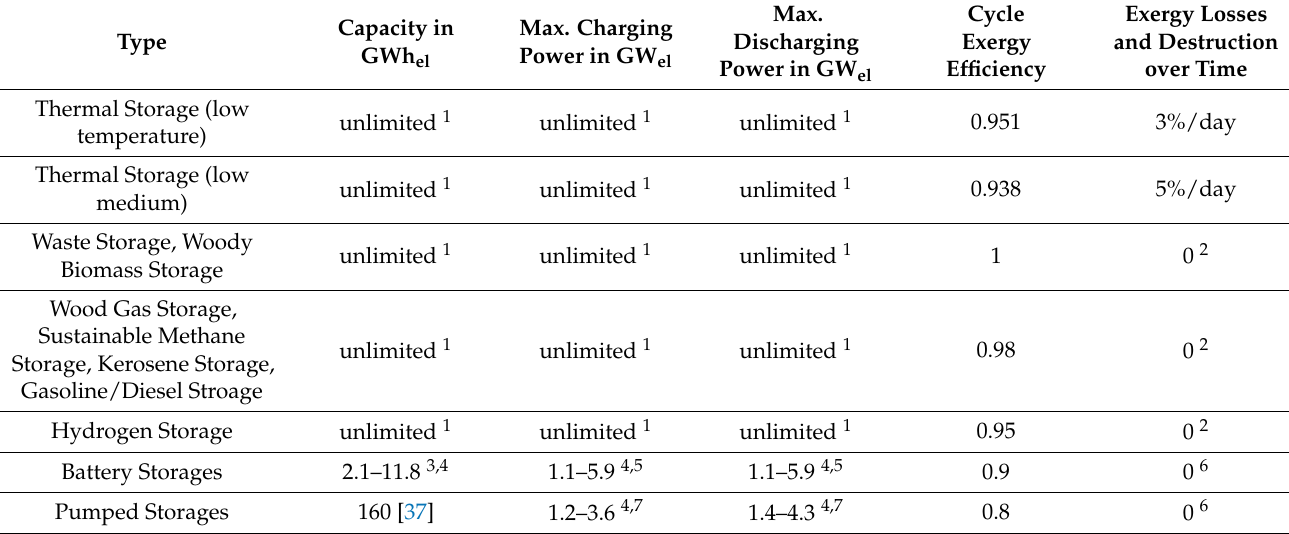
Table A9. Parameter of the used storages in the scenario Energy Efficiency